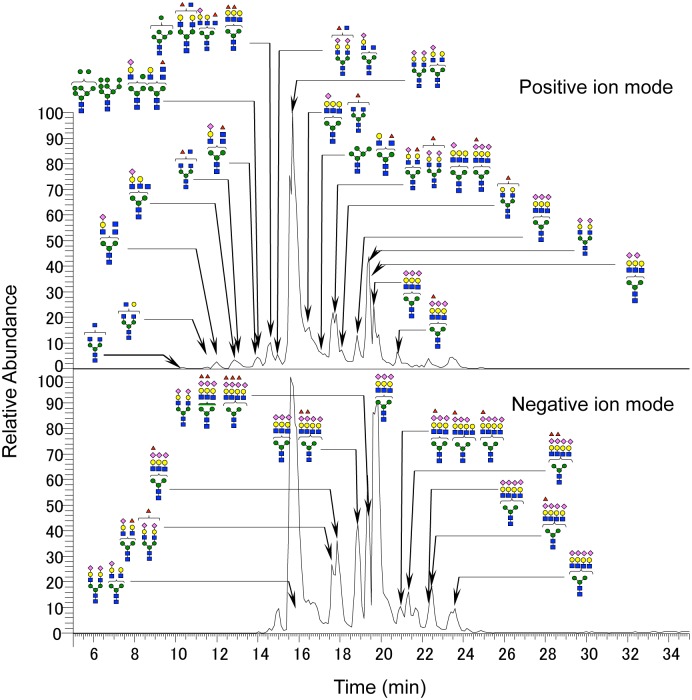
Typical N-glycan profile from plasma proteins in SSC.Deduced N-glycan structures were added to the base peak chromatogram of the SSC sample. Top and bottom charts represent the positive and negative ion modes, respectively. Vertical axis, relative abundance; horizontal axis, retention time; blue square, N-acetylglucosamine; yellow circle, galactose; green circle, mannose; purple diamond, N-acetylneuraminic acid; red triangle, fucose.